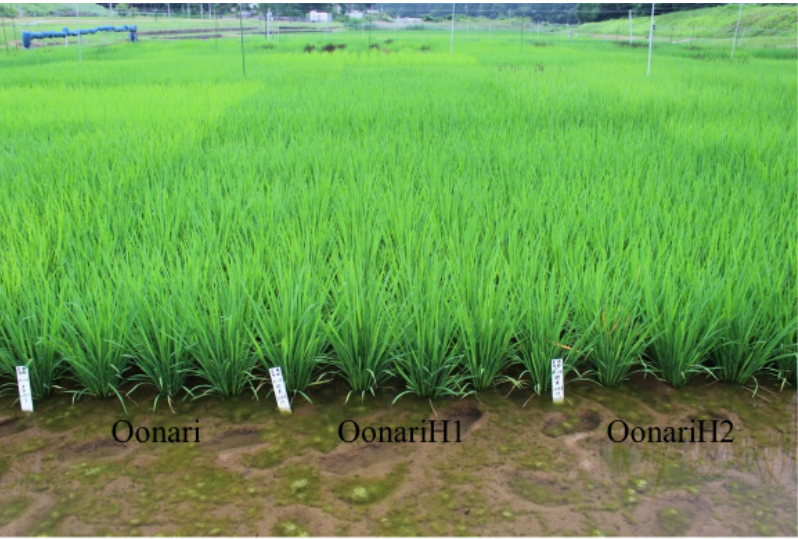
Figure 1. M 4 OonariH1 and OonariH2 at maximum tillering stage.